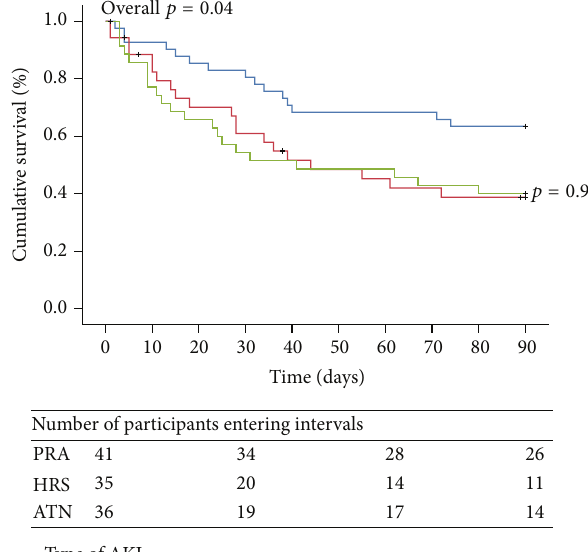
Figure 2: Ninety-day probability of survival of participants with cirrhosis by type of acute kidney injury. PRA (prerenal azotemia), HRS (hepatorenal syndrome), and ATN (acute tubular